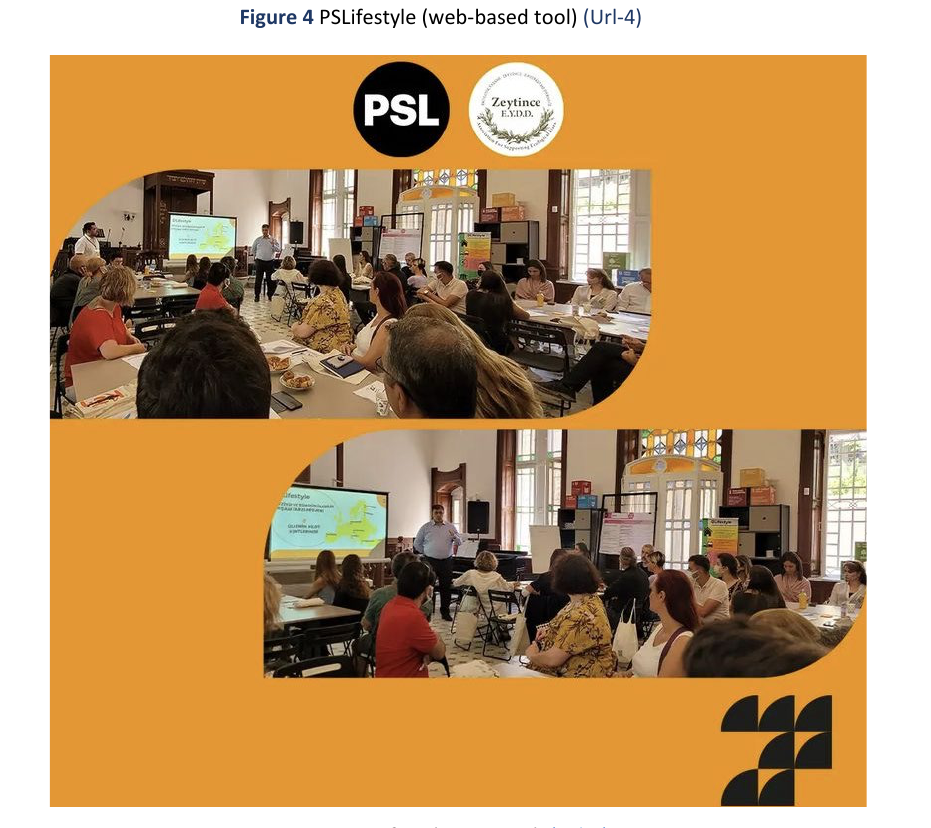
Figure 5 PSLifestyle Living Lab